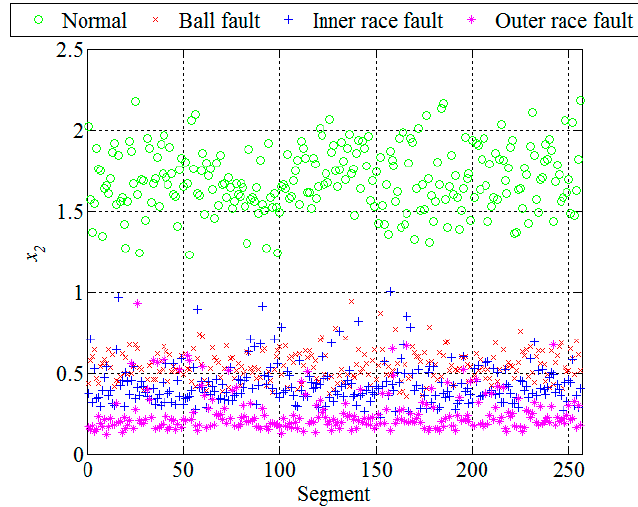
Figure 10. Standard deviation of the wavelet coefficients in the sub-band D 5